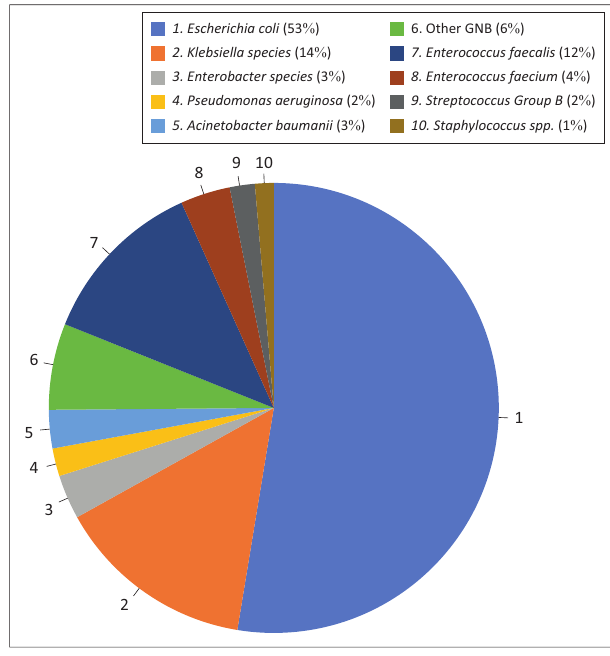
FIGURE 1: Distribution of the 3048 bacterial urinary pathogens isolated at the RK Khan Hospital, Durban, KwaZulu-Natal, South Africa, January 2018